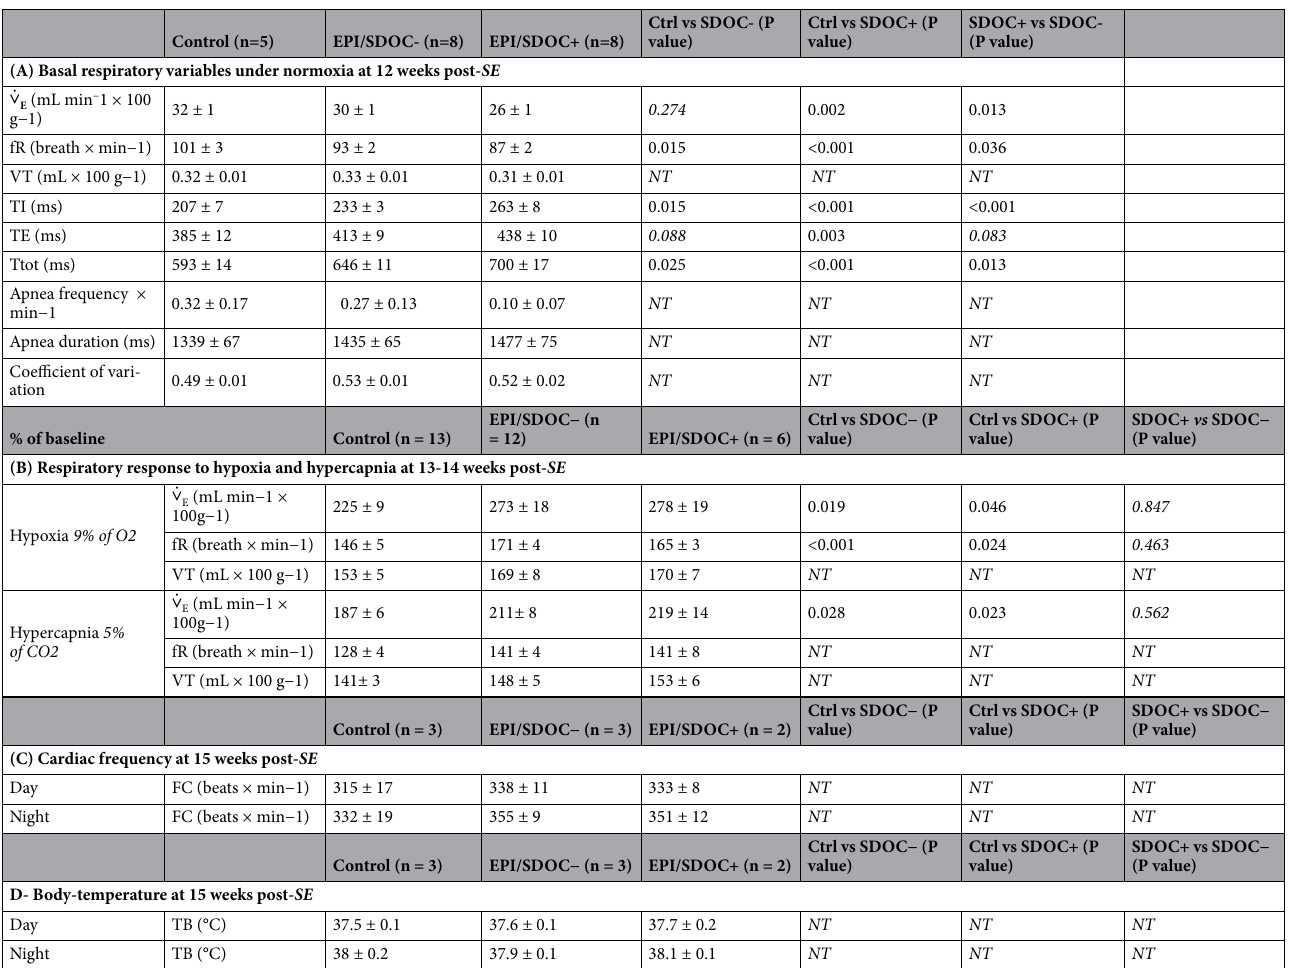
Table 1. Monitoring of cardiorespiratory functions in control and EPI rats between 12 and 15 weeks post-SE. Using plethysmography, ventilatory variables were measured under normoxic conditions (21% O 2 ) at 12